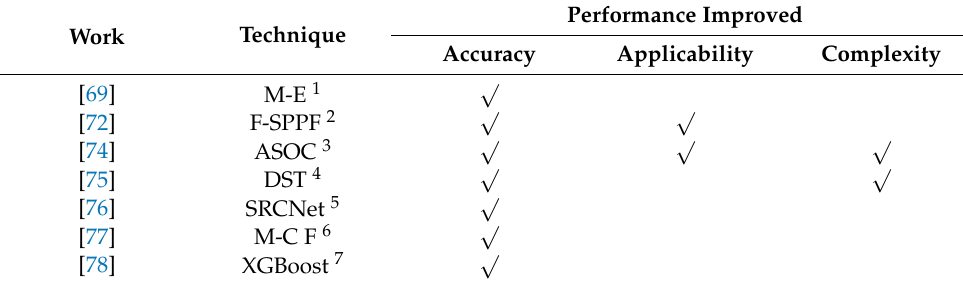
Table 9. Performance valuation of steganalysis methods based on FCB. Work